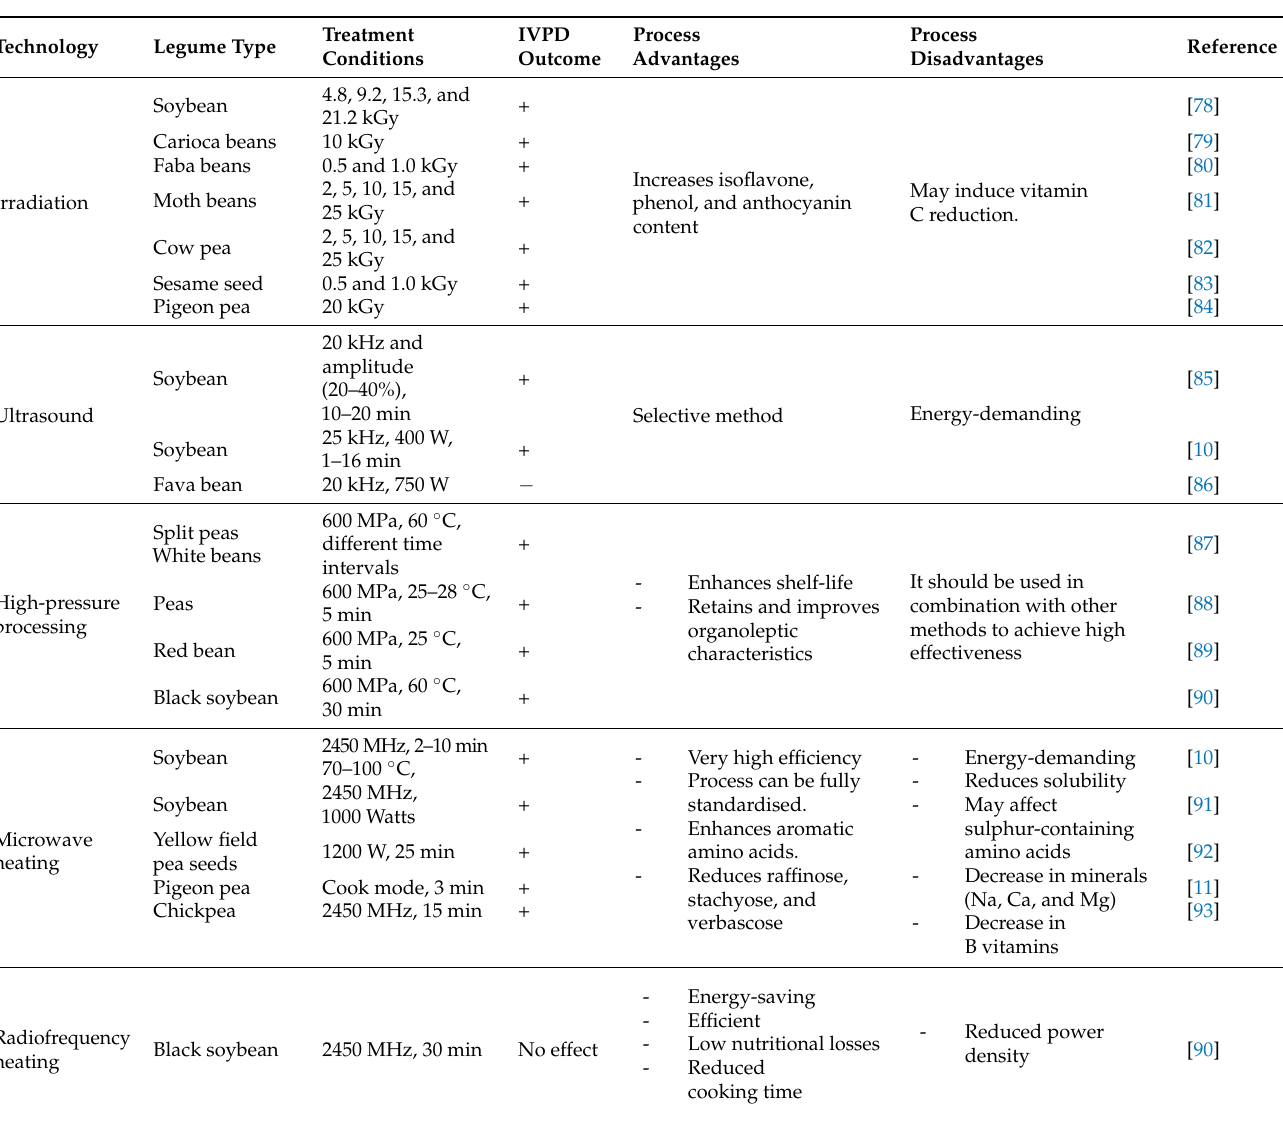
Table 1. Influence of emerging food processing technologies on the protein digestibility of selected legume